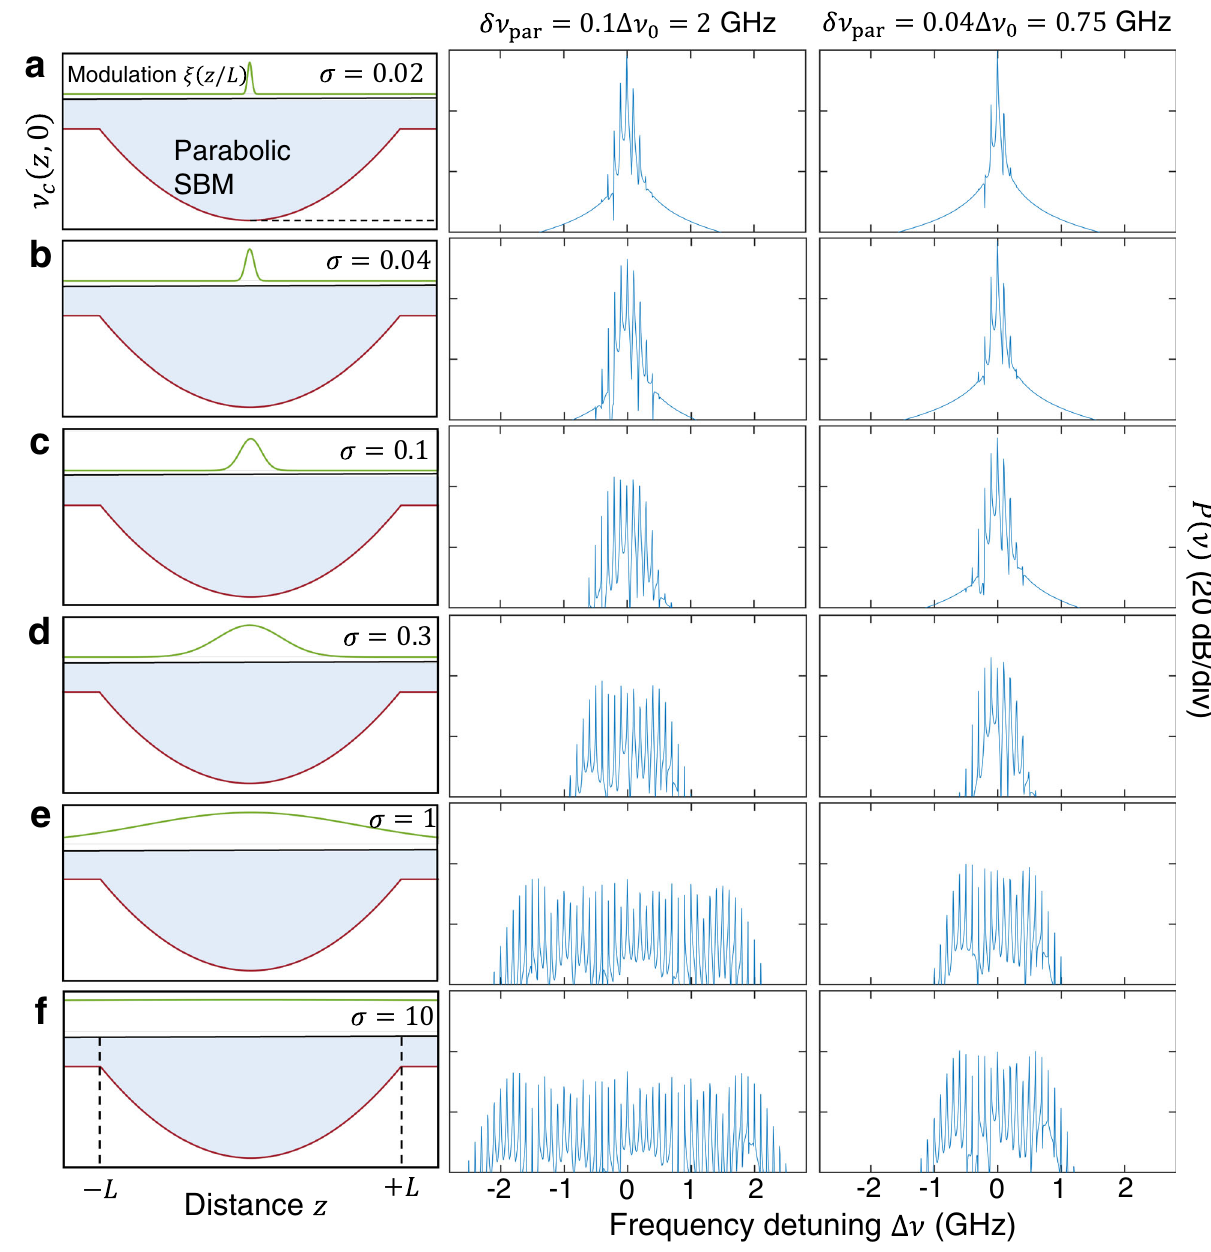
Fig. 3 Optical frequency combs (OFCs) generated by the adiabatic modulation of the parabolic SNAP bottle microresonator (SBM) with Gaussian (cid:1) (cid:3) ¼ e (cid:4) z = σ (cid:7) L ð Þ 2 , where σ is the dimensionless SDPM width and spatial distribution of the modulations (SDPMs). The SDPM (green line) is de fi ned by ξ z = L L is half the length of the SBM (red line). Rows show the OFC generated with different values of σ for two modulation amplitude maxima: δ ν par ¼ 0 : 1 Δ ν 0 ¼ 2 GHz and δ ν par ¼ 0 : 04 Δ ν 0 ¼ 0 : 75 GHz. a A limited number of comb resonances are formed at σ ¼ 0 : 02 for both values of δ ν par, when the SDPM is strongly localized near the centre of the SBM. b – e The OFC spectrum becomes wider and fl atter with growing σ . For δ ν par ¼ 0 : 75 GHz, the OFC has a smaller bandwidth, though the power level is ~ 10 dB higher than in the case of δ ν par ¼ 2 GHz. f The generated OFC achieves its optimal shape for a close to uniform SDPM, when σ ¼